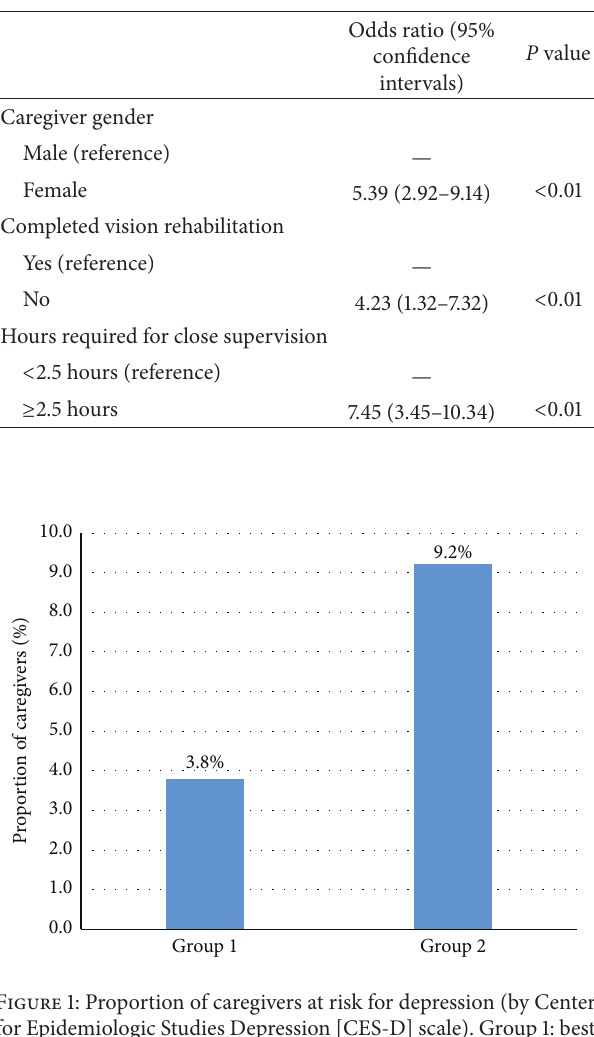
Table 4: Covariates impacting the risk of depression among care- givers in the logistic regression model.